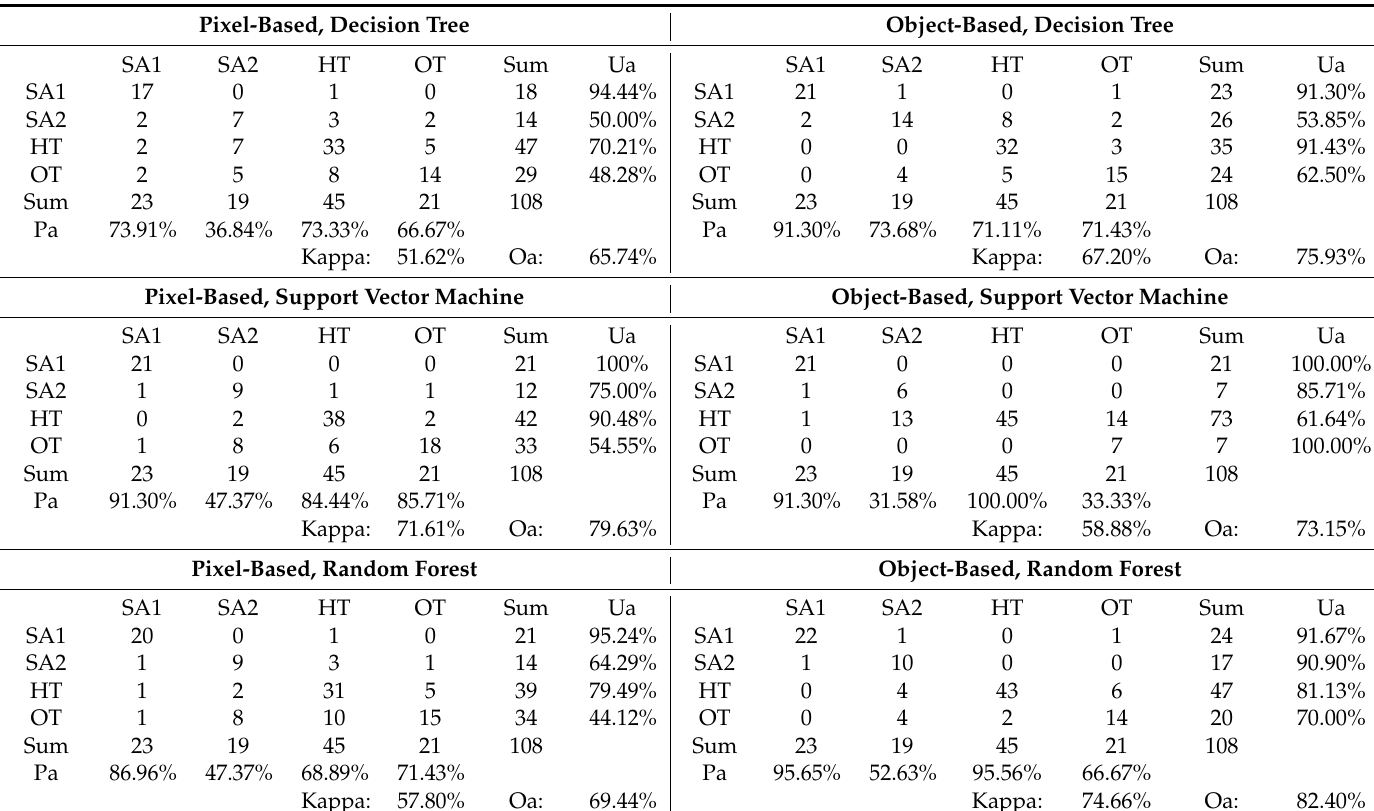
Table 2. Confusion matrices and associated classifier accuracies based on test data. SA1 = Sonneratia apetala group 1 , SA2 = Sonneratia apetala group 2 , HT = Hibiscus tiliaceus , OT = other mangroves. Oa = overall classification accuracy, Pa = producer’s accuracy, Ua = user’s